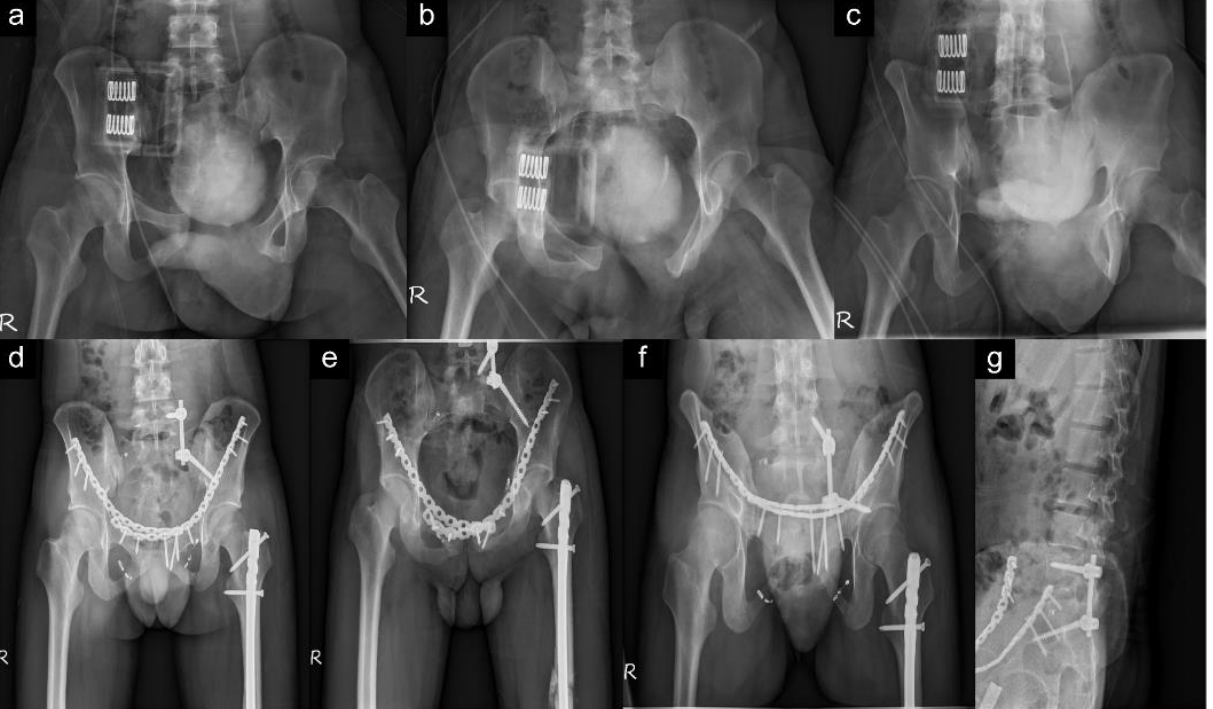
Figure 4. A 27-year-old man with anterior and posterior pelvic ring injury. The “R” on the plane radiography represents the right side of the patient. ( a – c ) Preoperative pelvic radiology series (an- teroposterior, inlet, and outlet views) showing right sacral fracture (Denis zone II) with diastasis of the bilateral sacroiliac joint and of pubic symphysis with fracture of the left anterior pubic ramus. ( d – f ) Postoperative pelvic radiology series (anteroposterior, inlet, and outlet views) demonstrating bilateral percutaneous sacroiliac screws, minimally invasive spinopelvic fixator, and dual plate fix- ation for anterior pelvic ring. ( g ) Postoperative lumbar and sacral lateral view showing good posi- tion of sacroiliac screw and spinopelvic fixator of the L5 and ilium.